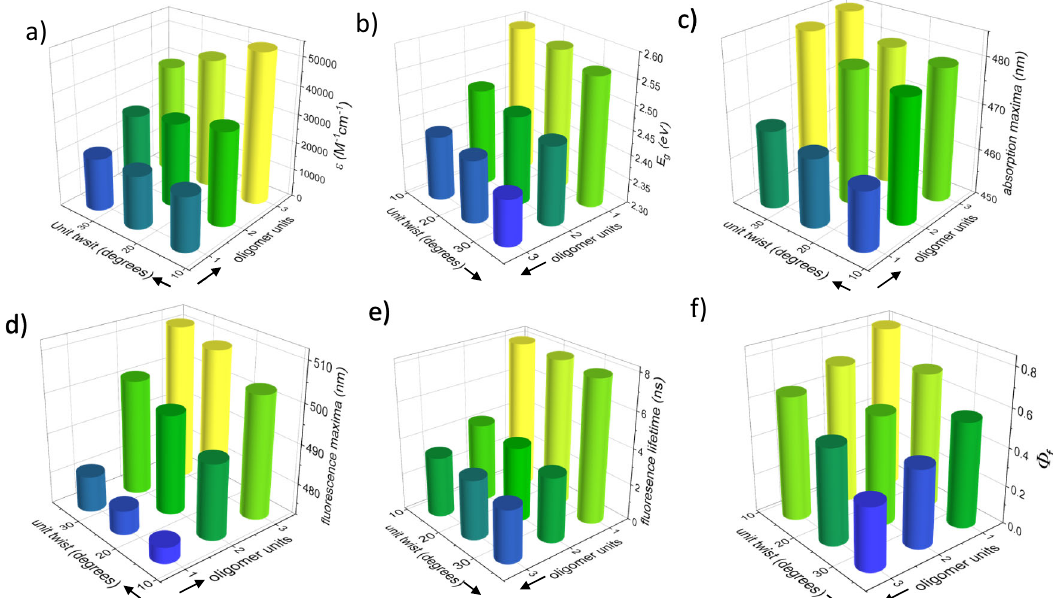
Fig. 4 The effect of backbone twist and length on the photophysical properties. 3D graphs displaying the effect of backbone unit twist ( y -axis) and backbone length ( x -axis) on a extinction coef fi cients at maximal absorption; b optical bandgaps ( E g ); c absorbance maxima (from the onset of the lowest energy band); d fl uorescence maxima; e fl uorescence lifetime; and f fl uorescence quantum yields ( Φ f ) of Ant-Cn monomers, dimers, and trimers. The colors portray the z -axis value, from lowest (blue) to highest